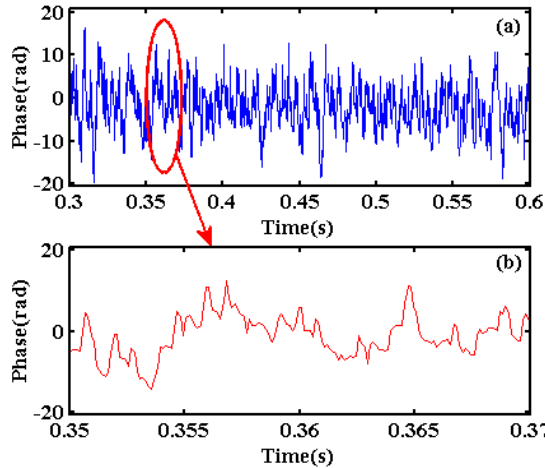
Figure 11. ( a ) Phase curve and ( b ) its partial enlargement at the vibration position.